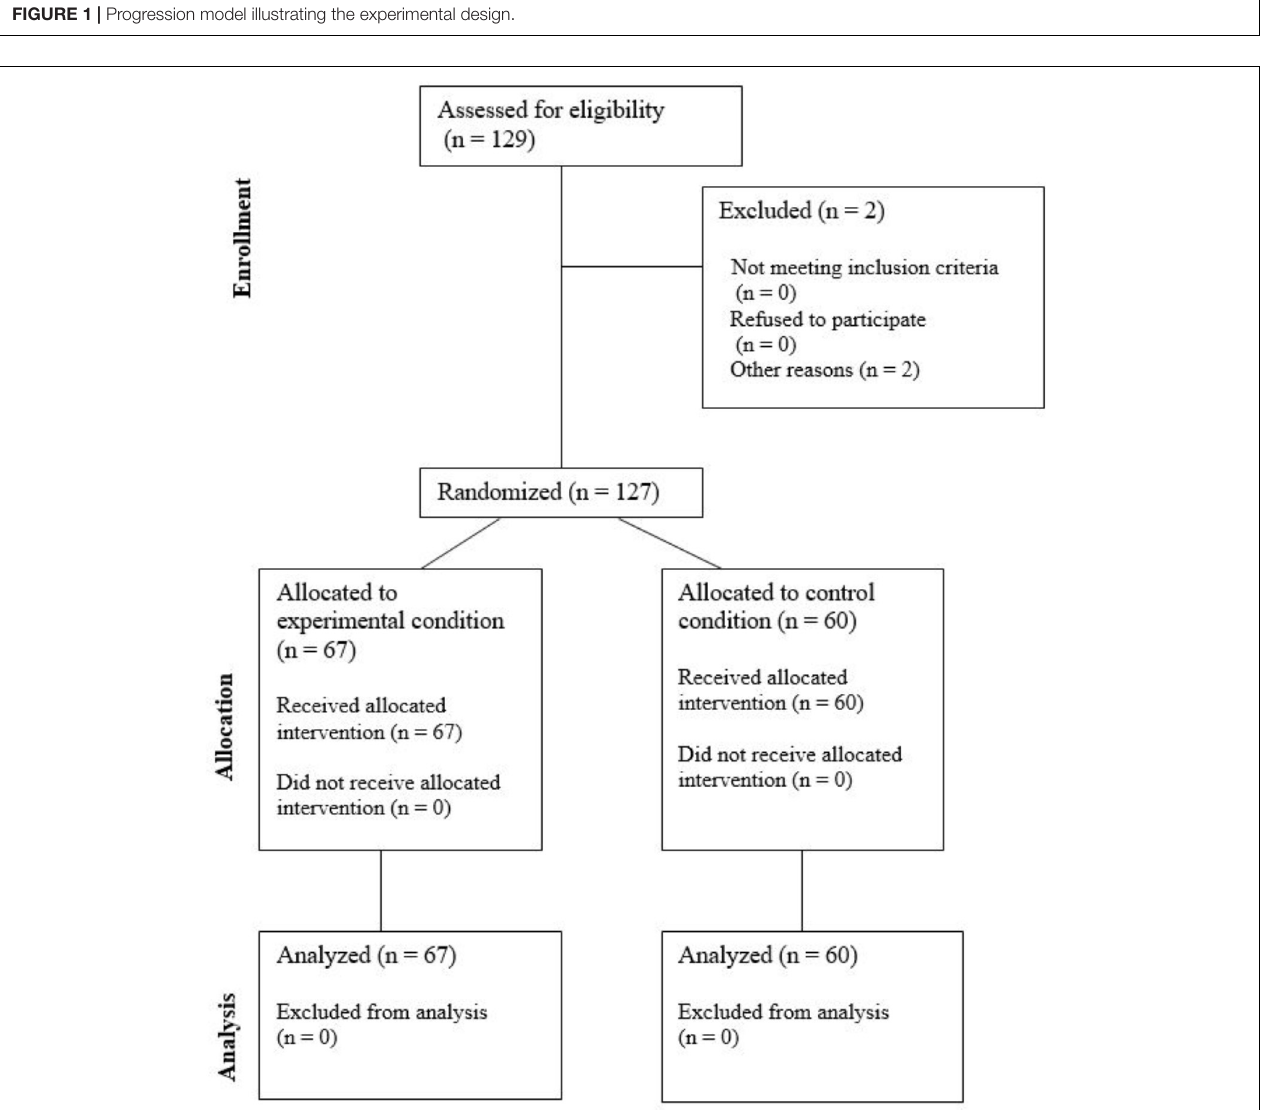
FIGURE 2 | Flowchart participant